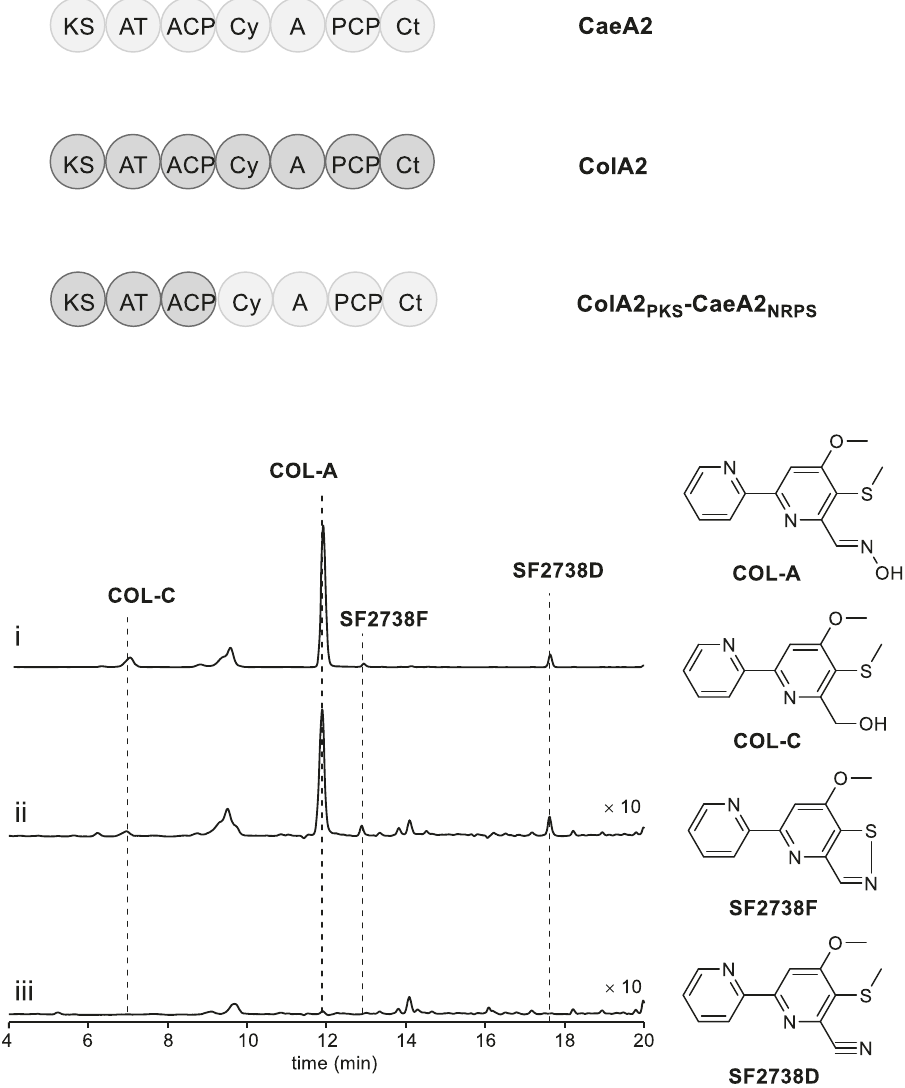
Fig. 6 Domain organization of the NRPSs CaeA2, ColA2, and ColA2 PKS- CaeA2 NRPS (Top) and HPLC analysis of COL-related products in S. roseosporus strains (below). i, the wild-type COL-producing strain (positive control); ii, the Δ colA2 mutant in which a chimeric gene colA2 PKS- caeA2 NRPS is expressed in trans; and iii, the Δ colA2 mutant (negative